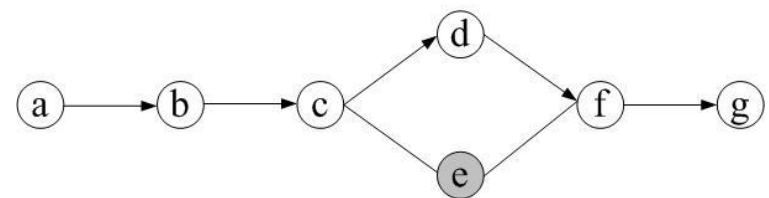
Figure 5. A simple example for secure path in